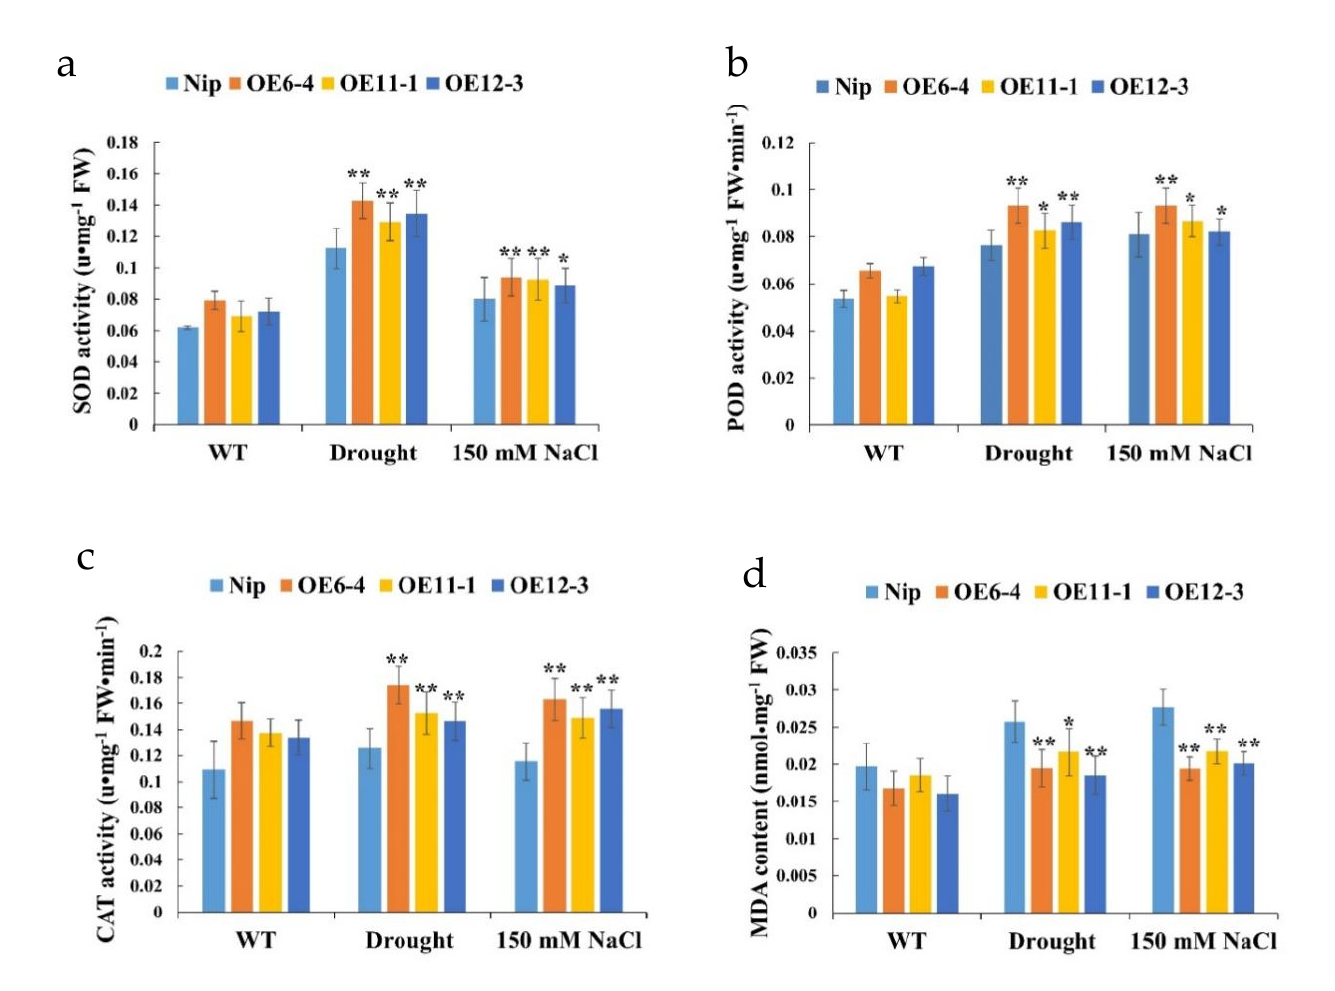
Figure 9. Physiological activity of WT and transgenic plants in response to drought and salt stresses. ( a ) SOD activity. ( b ) POD activity. ( c ) CAT activity. ( d ) MDA content. WT: wild-type rice; OE6-4, OE11-1, and OE12-3 are three independent transgenic lines. Values are mean ± SE ( n = 3). Asterisks indicate significant differences between transgenic lines and WT (* p < 0.05, ** p < 0.01). n = 20 plants per treatment.